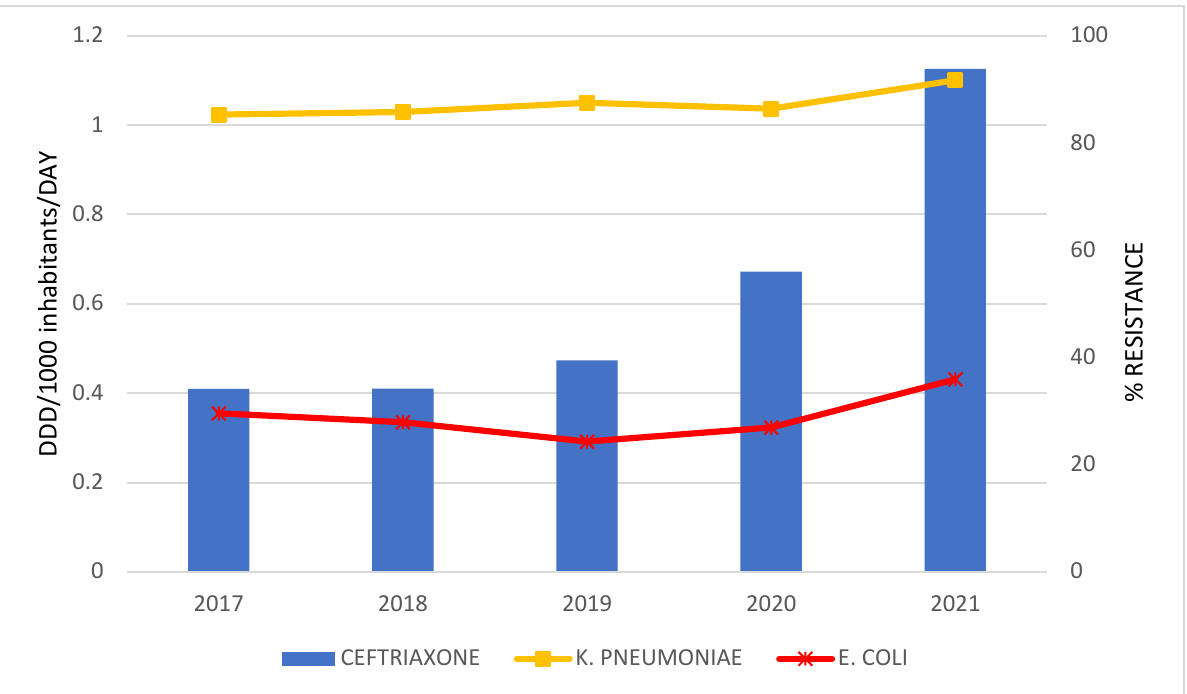
Figure 2. The correlation of meropenem consumption and the resistance to meropenem in bacteria during 2017 – 2021.